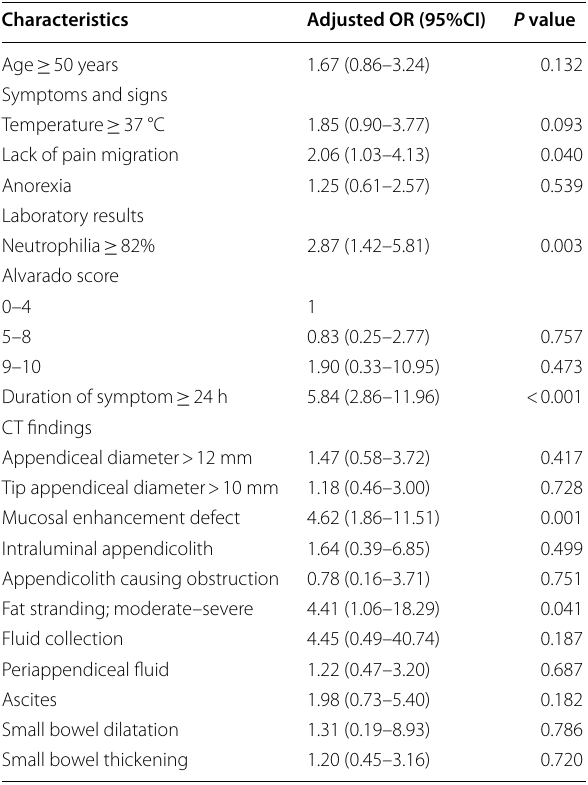
Table 5 Multivariate regression analyses of demographic 1 and CT 2 data